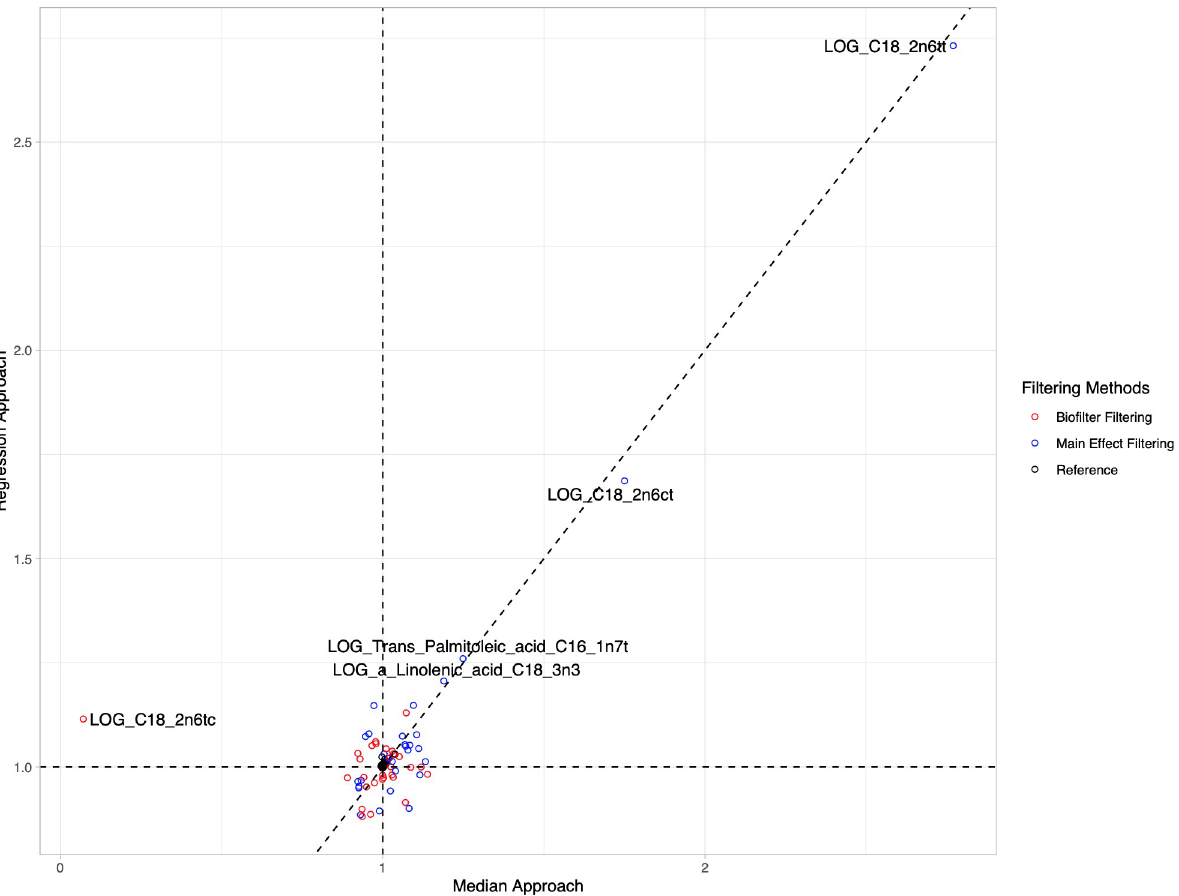
Fig 3. Comparison of model inflation based on genomic inflation factor among different approaches. The model inflation for each interaction was calculated (S3 Table) using the median approach and regression approach for different filtering methods (Red: Biofilter filtering, Blue: Main effect filtering, and Black: Reference). The horizontal and vertical black dotted lines represent the inflation factor at 1 for different approaches. The line of equality was also plotted for viewing the estimation differences from models. Five models with comparably large inflation were labeled.